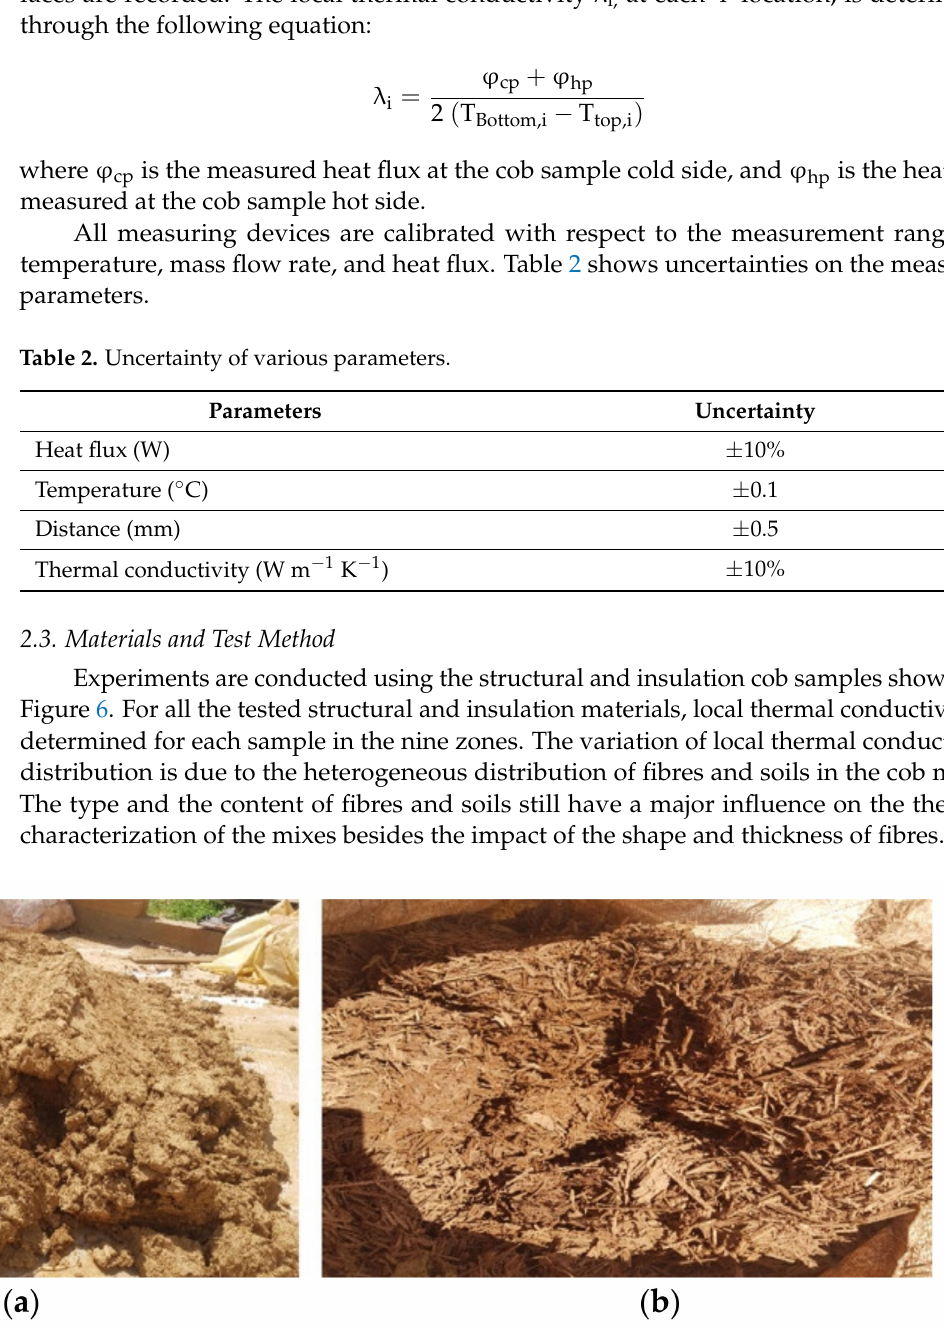
Figure 6. Photos of the studied cob mixes: ( a ) structural cob material, ( b ) insulation cob